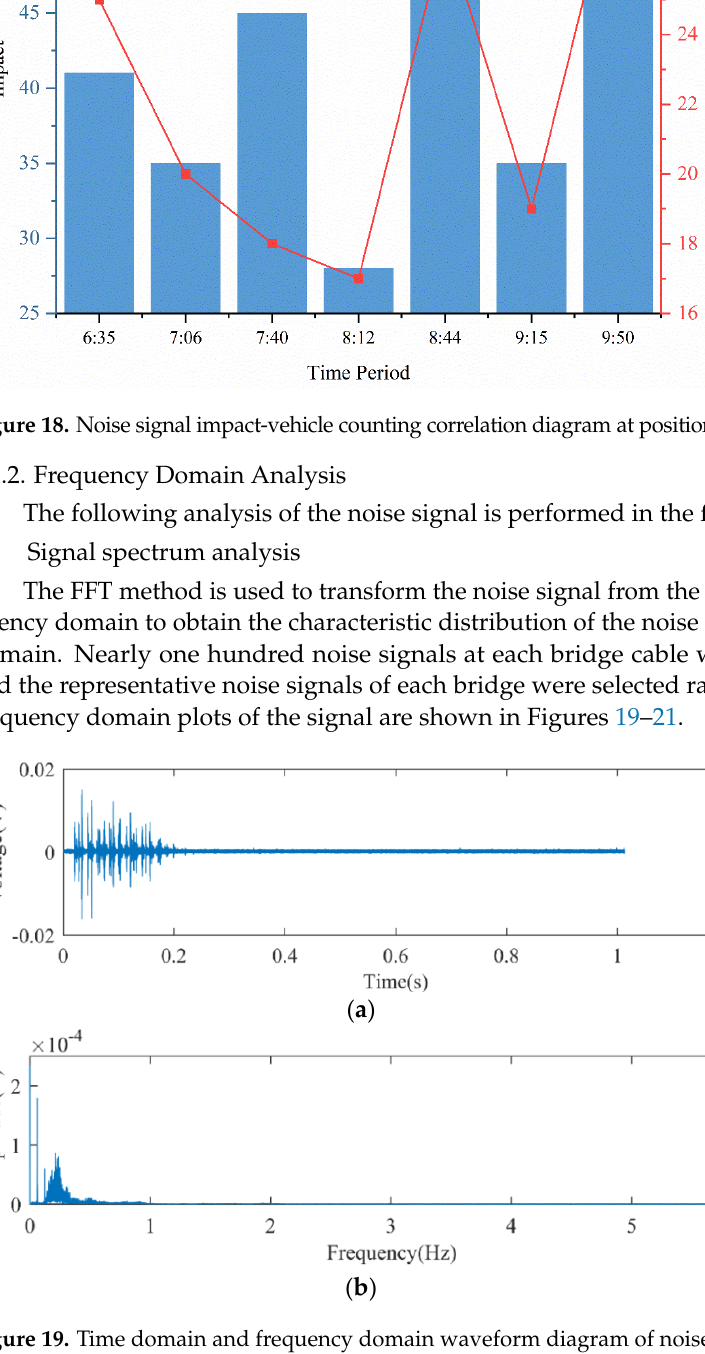
Figure 17. Noise signal impact-vehicle counting correlation diagram at position 1 of Yellow River Bridge.